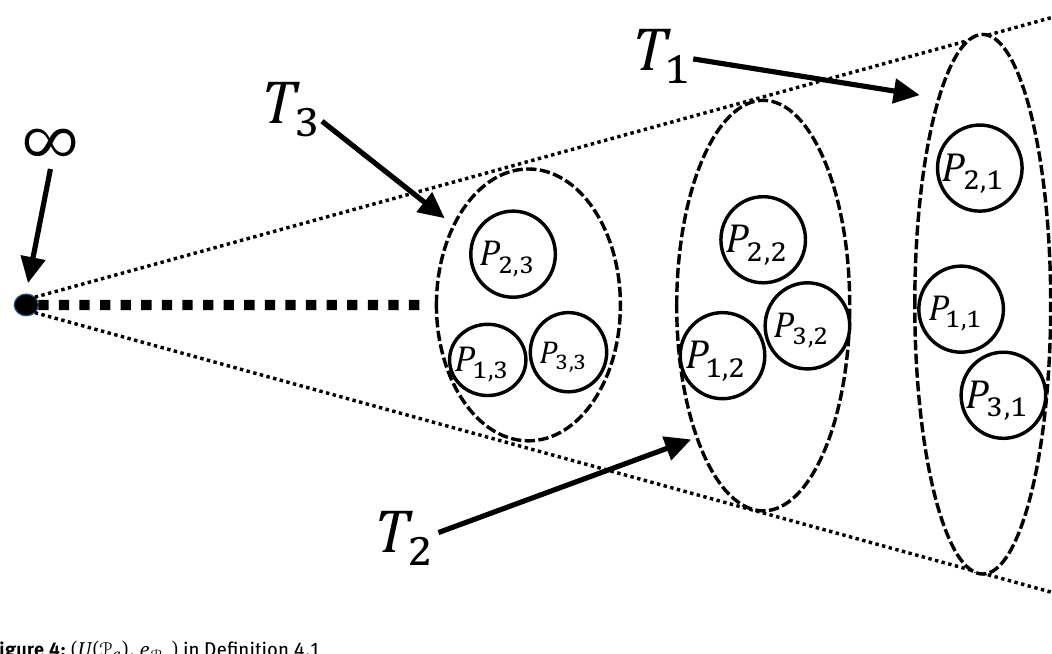
Figure 4: ( U ( P q ), e P